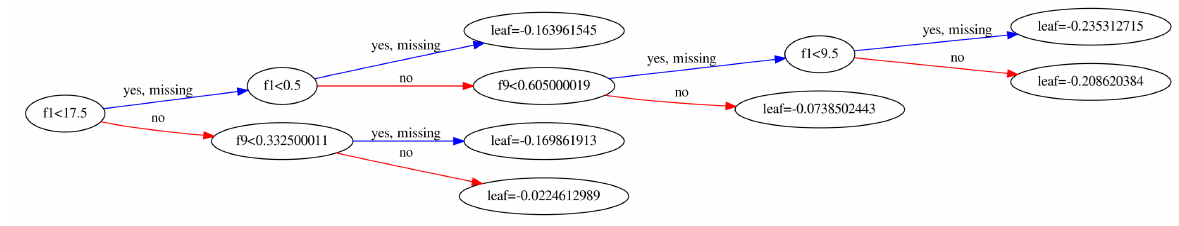
Figure 7. First decision tree for XGBoost prediction